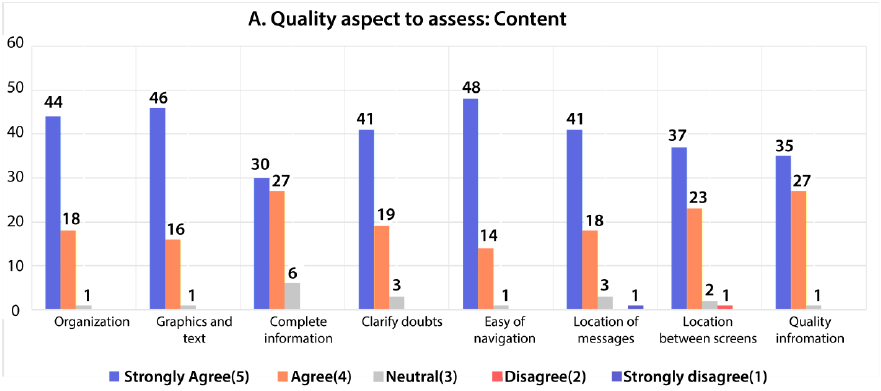
Figure 18. Evaluation by users about the content of the platform.